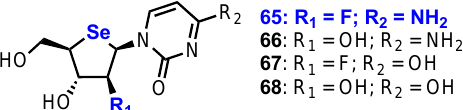
Figure 5. Structures of 2’ - substituted 4’ -selenoarabinofuranosyl pyrimidine analogues 65 – 68 .